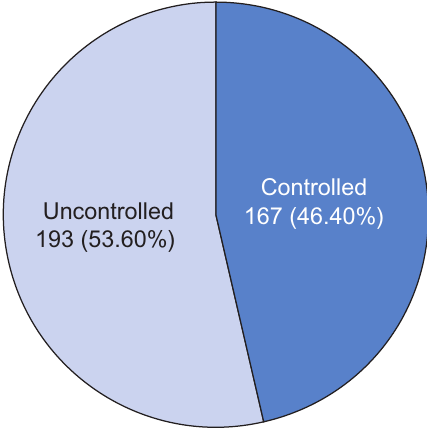
Figure 1: Pattern of blood pressure control among respondents. Table 1: Comparison of blood pressure control in the three clinics